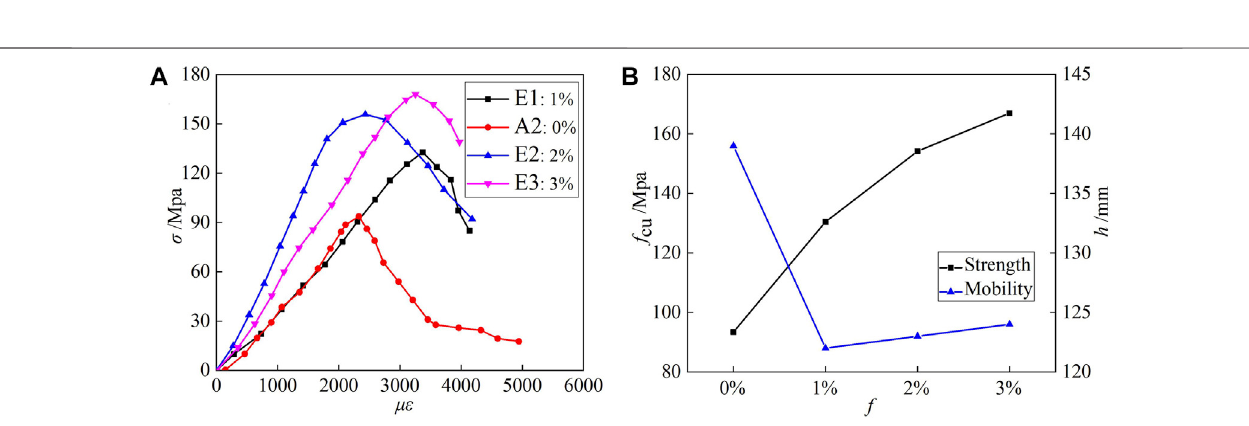
Frontiers in Materials |